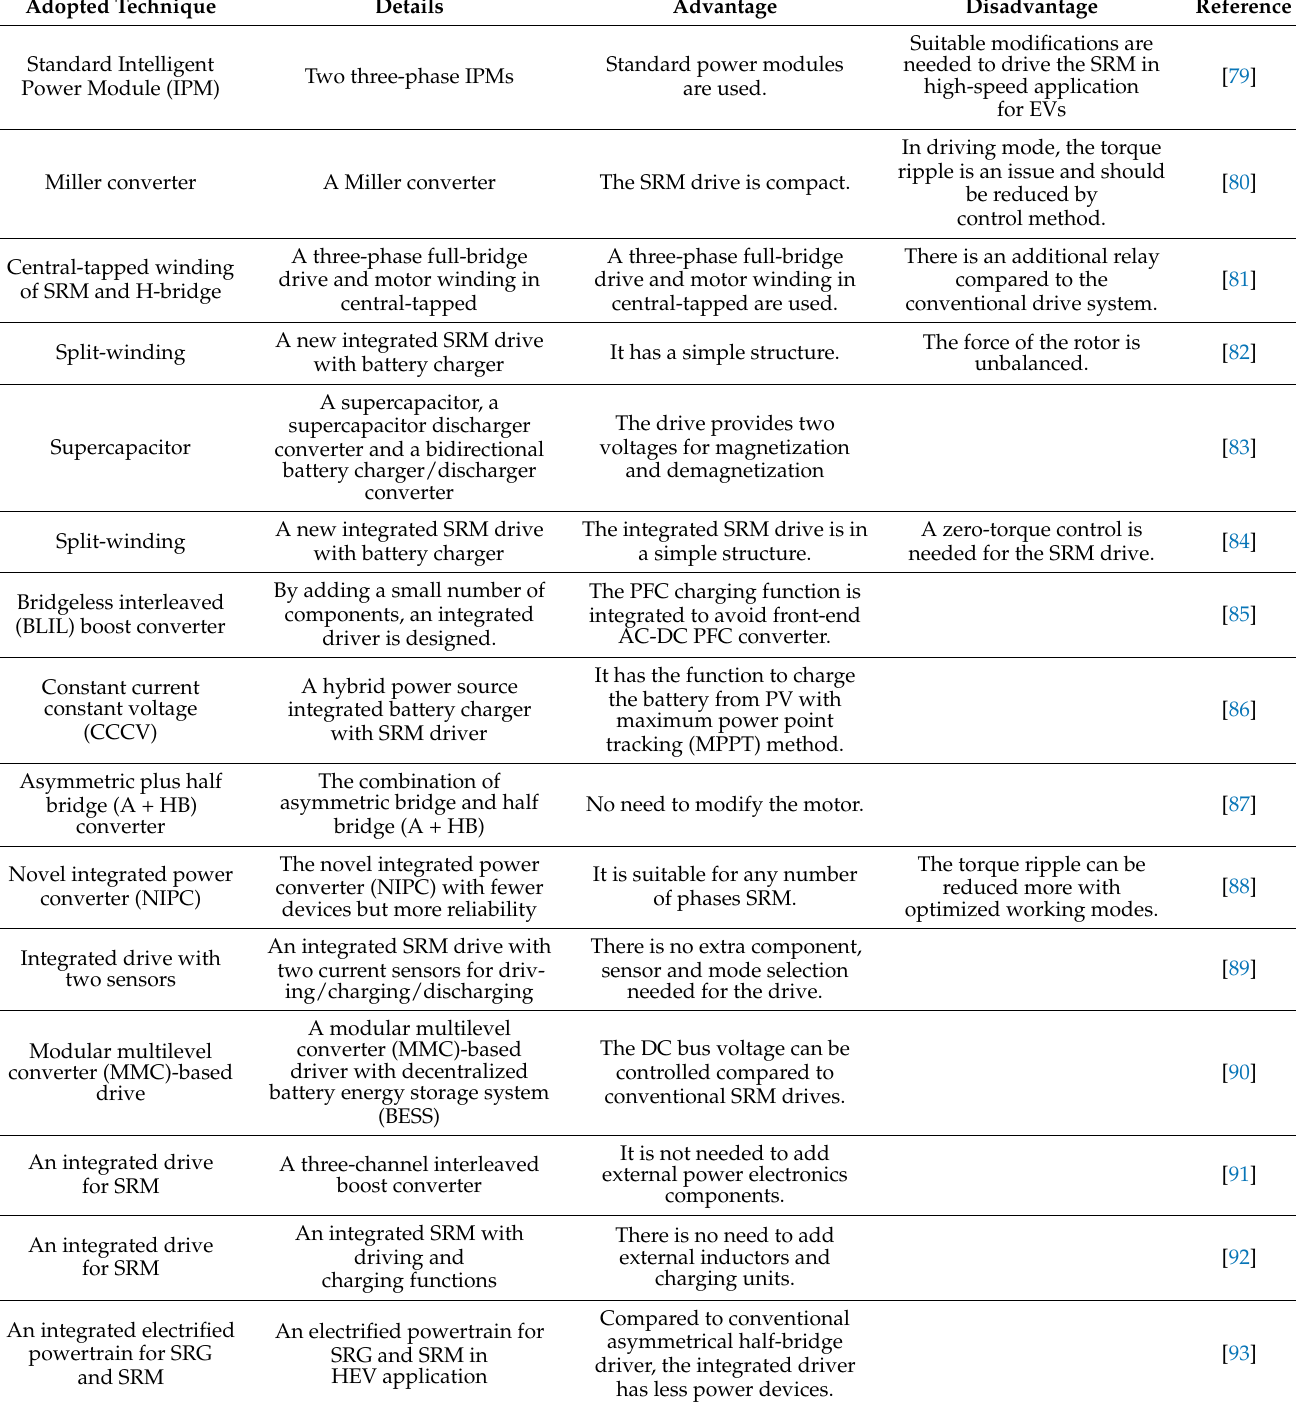
Table 3. Summary of the integrated charger with SRM